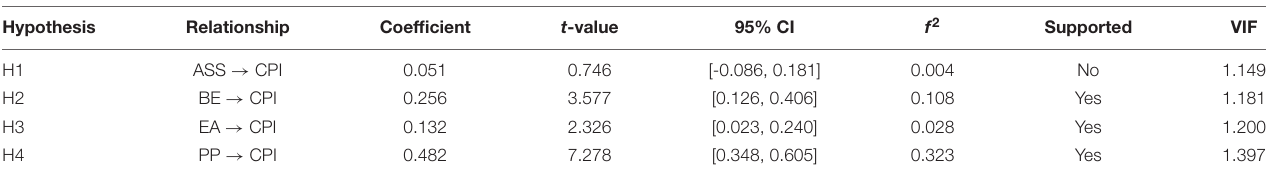
TABLE 4 | Results of hypothesis